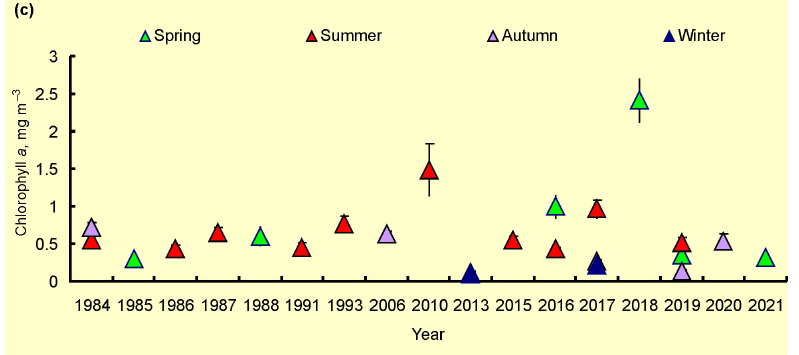
Figure 7. Temporal variation in SST, °C ( a ), SSS, psu ( b ), and Chl ‐ a, mg m –3 ( c ) in the Barents Sea, 1984–2021. Analysis of summer and combined data for the Kola Section indicated that there